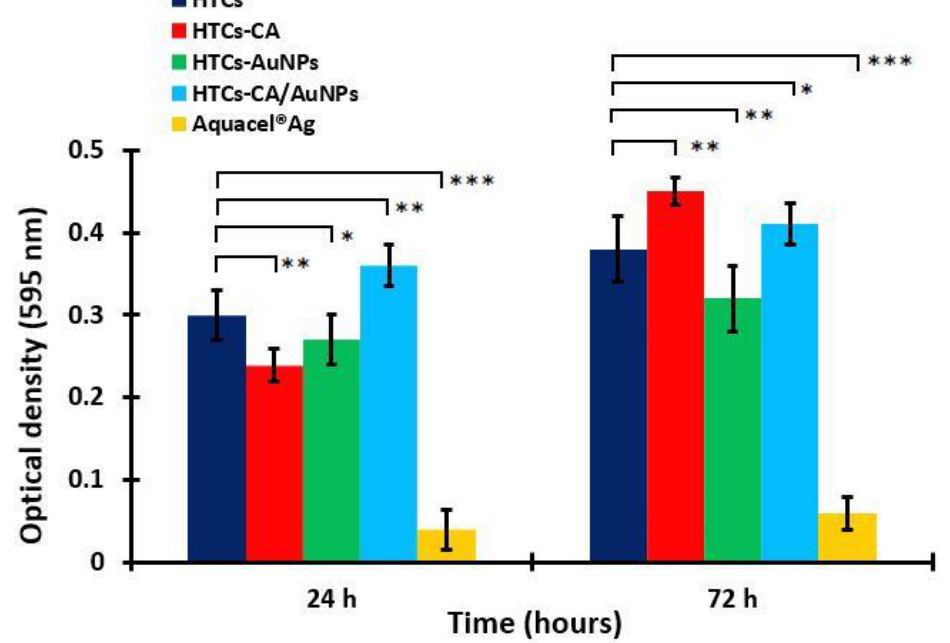
Figure 4. Cell proliferation of the developed nanofibrous mats: HTC, HTC-CA, HTC-AuNPs and HTC-CA/AuNPs. Aquacel ® Ag was the positive control an in both test. (Data are presented as mean ± S.D., (* P < 0.05; ** P < 0.01; *** P < 0.001); n = 3. (CA refers to capsaicin).